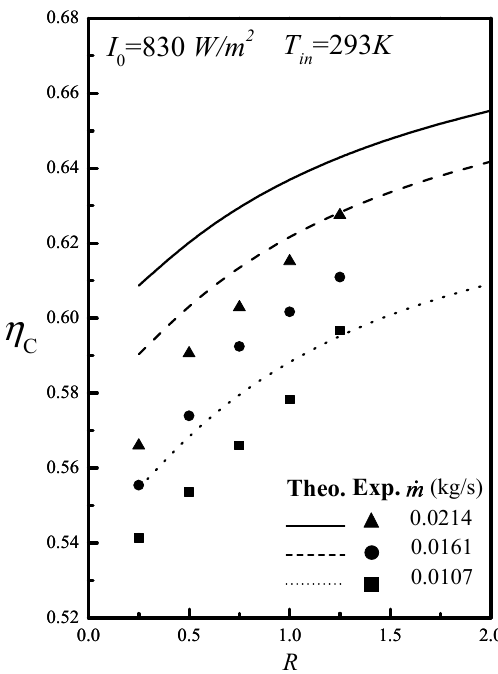
Figure 4. Effect of the recycle ratio on collector efficiency of the recycling cross-corrugated solar air collector ( I 0 = 830 W/m 2 ).